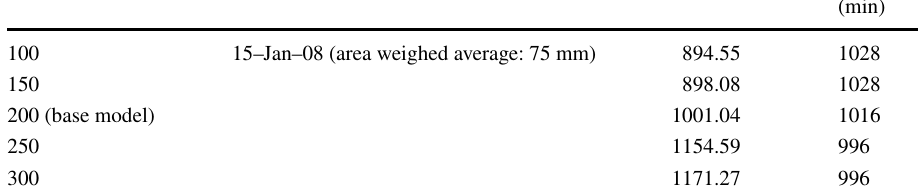
Table 7 Flood properties of calibrated GSSHA base model for flood event of January 15, 2008, compared to hydrographs corresponding to GSSHA models with cell sizes of 100–300